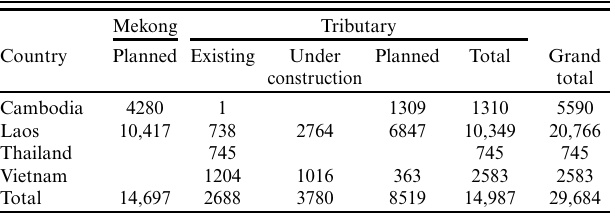
Table 3. Energy generation capacity of dams in the lower Mekong basin (MW). Source: MRC (2011 b ).